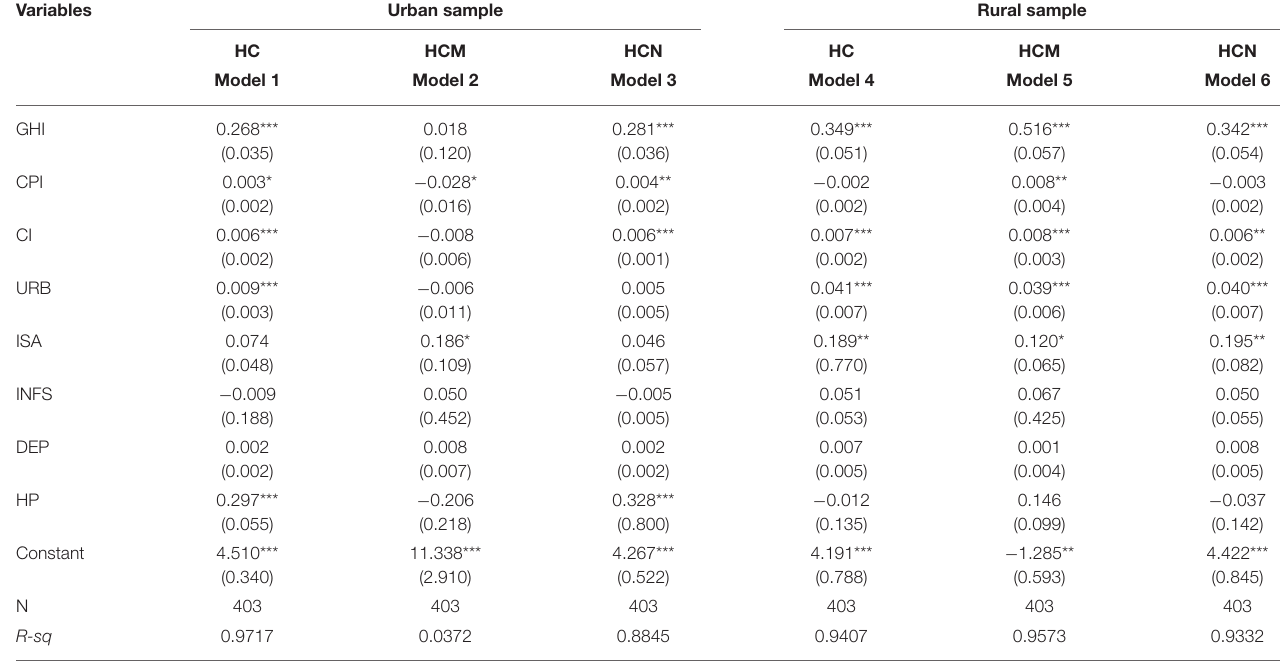
TABLE 4 | Heterogeneity analysis of urban and rural